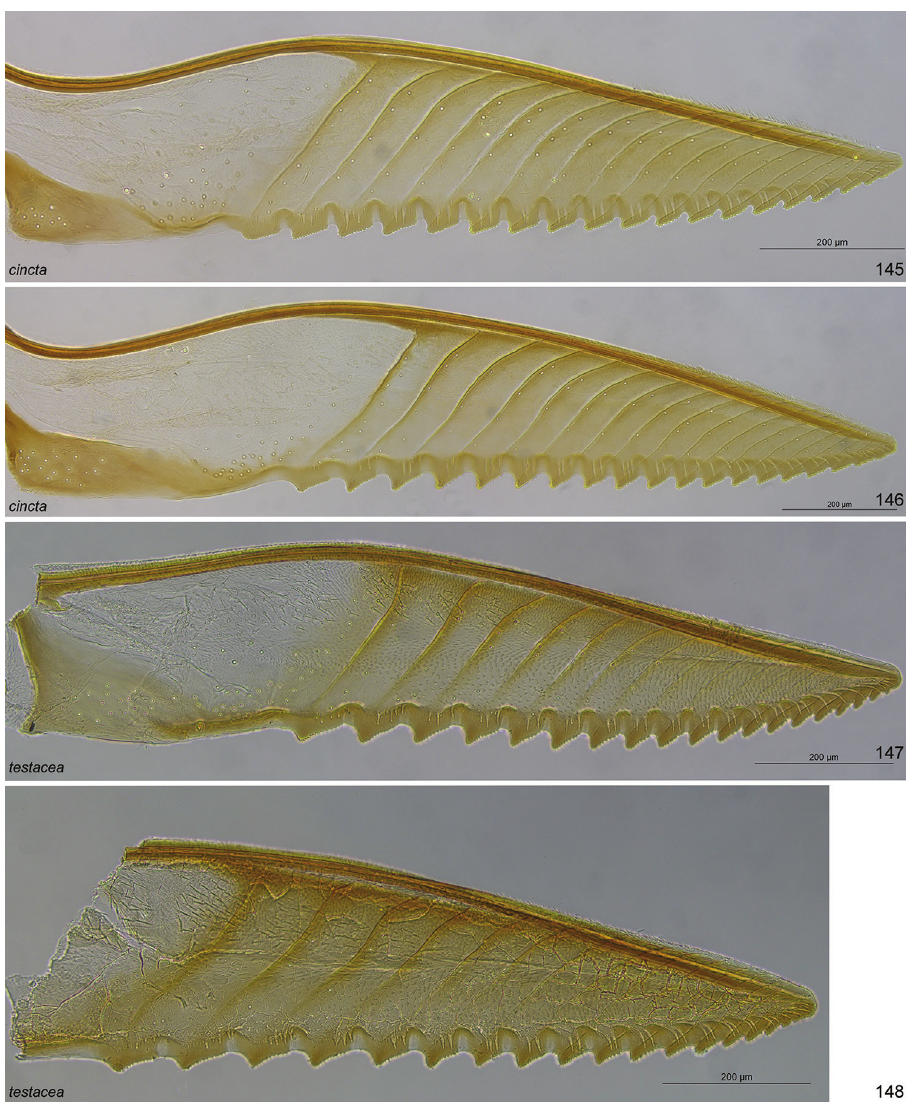
Figures 145–148. Lancets of Pristiphora . 145 cincta PR.581VV, oviposited in the leaves of Vaccinium myrtillus 146 cincta PR.582VV 147 testacea DEI-GISHym31638 148 testacea , holotype of gaunitzi